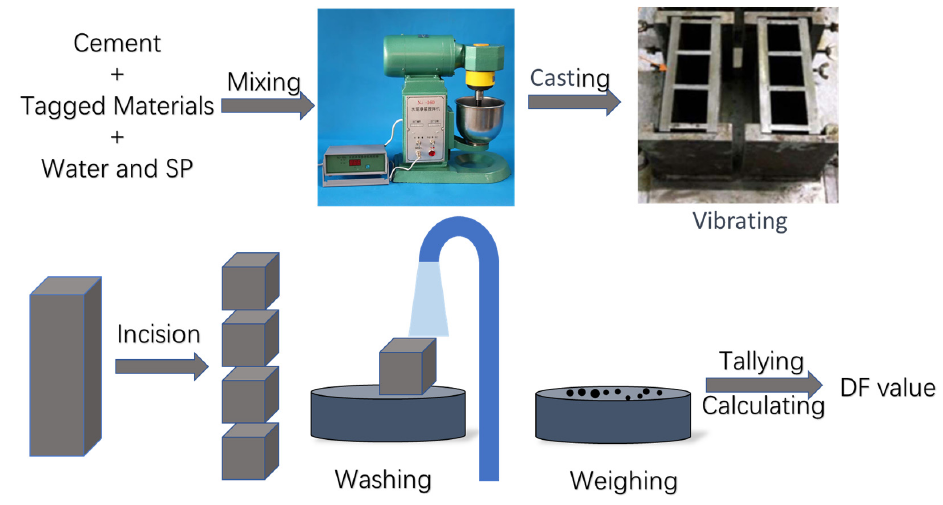
Figure 1. Schematic diagram of main experimental procedures. The mix proportions used in this study for each section are listed in Table 1. Table 1. Mix ratio of cement paste in this study.